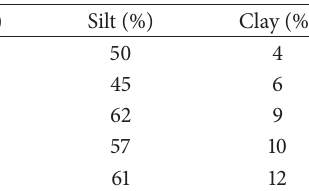
Table 1: The physical properties of the silt mixtures used in